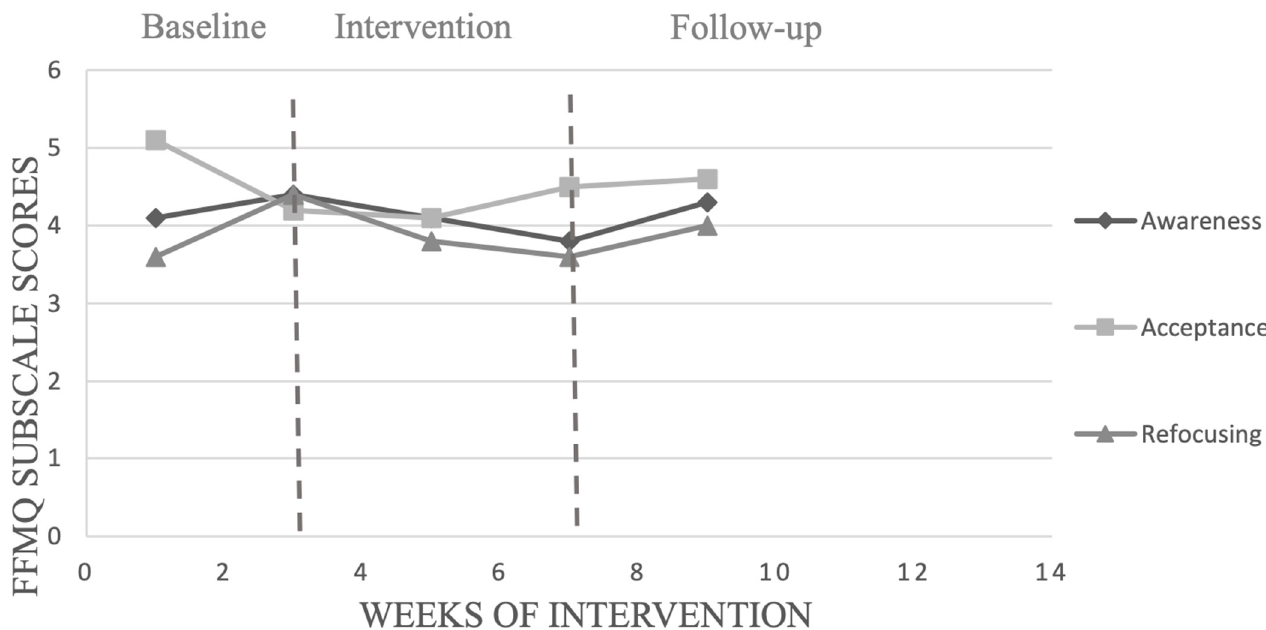
Figure 4. Evolution of scores obtained on the MIS by participant 10, across the weeks of interventions.